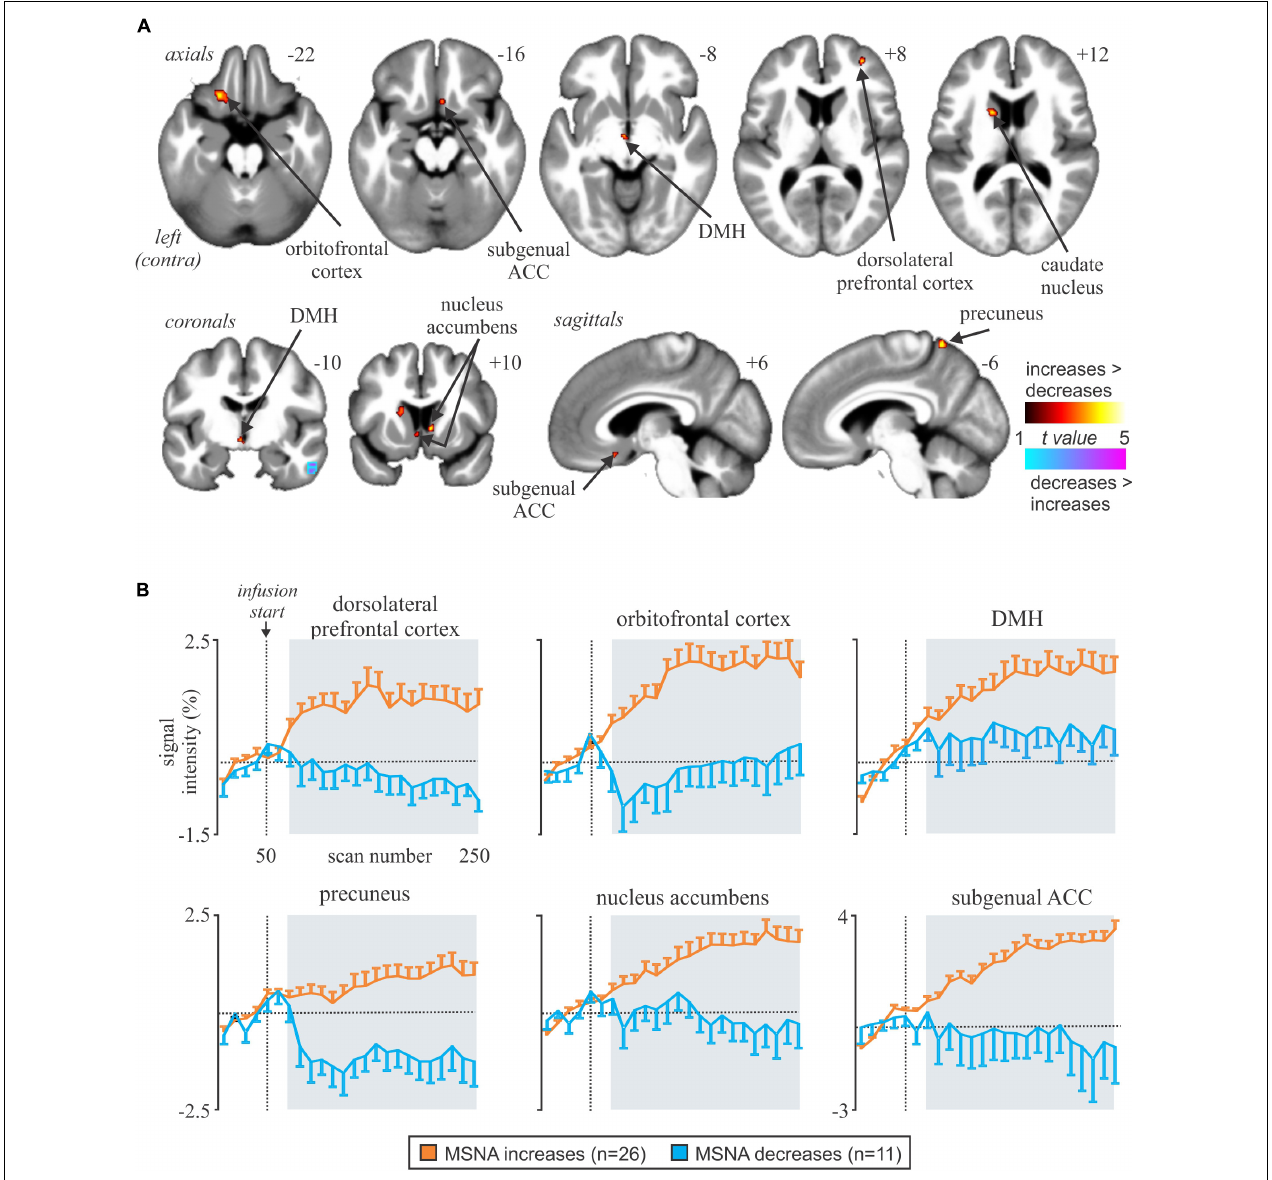
FIGURE 5 | (A) Brain regions in which increases in BOLD signal intensity were greater or lower during tonic muscle pain. Significant clusters are overlaid onto a mean T1-weighted anatomical image set created from all 37 subjects. Slice locations in MNI space are indicated in the upper right of each image. The left side of the image is the side contralateral to the noxious stimulus. (B) Plots of mean ( ± SEM) percentage changes, measured every 5 min, at baseline and during pain (gray shading) in the increasing (orange) and decreasing (blue) groups. Reproduced, with permission, from Kobuch et al.